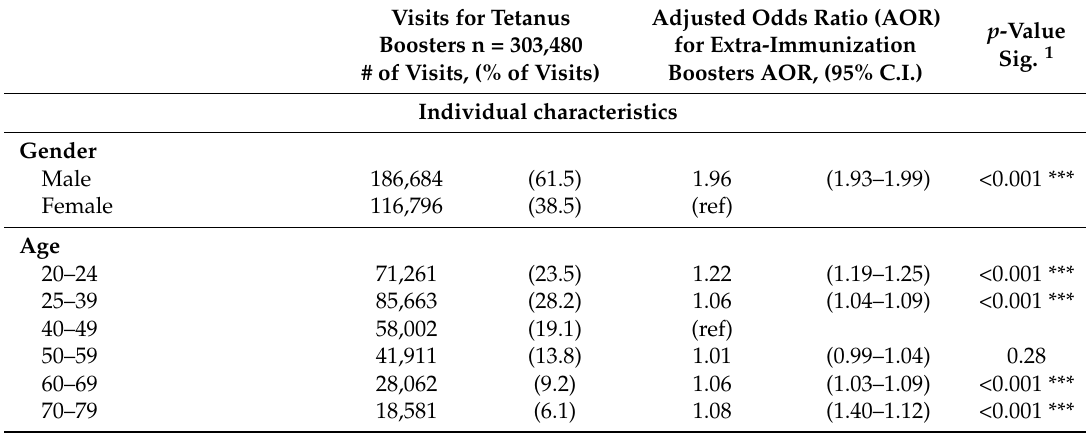
Table 3. Characteristics of visits for tetanus boosters and adjusted odds ratios for extra-immunized tetanus boosters among tetanus booster recipients aged between 20 and 79 years in Taiwan. (2006–2013; recipient number, 214,847; visit number,